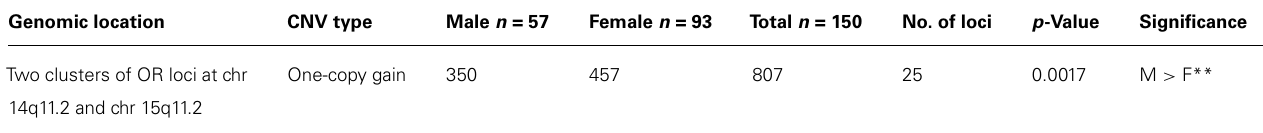
Table 9 | Sex bias in one-copy gain in two clusters of OR loci at chr 14q11.2 and chr 15q11.2. Genomic location